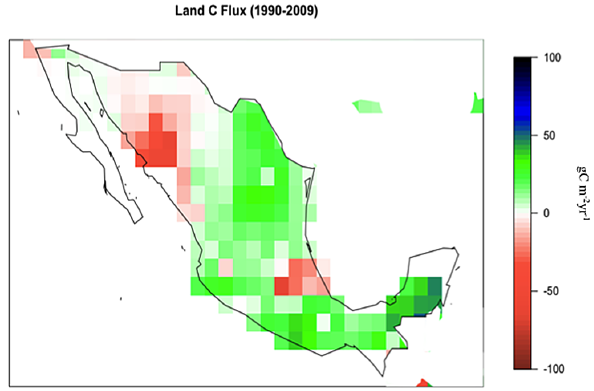
Figure 5. Land C flux (NBP) for the period 1990–2009 (gCm − 2 yr − 1 ) . A positive value indicates a C sink and vice